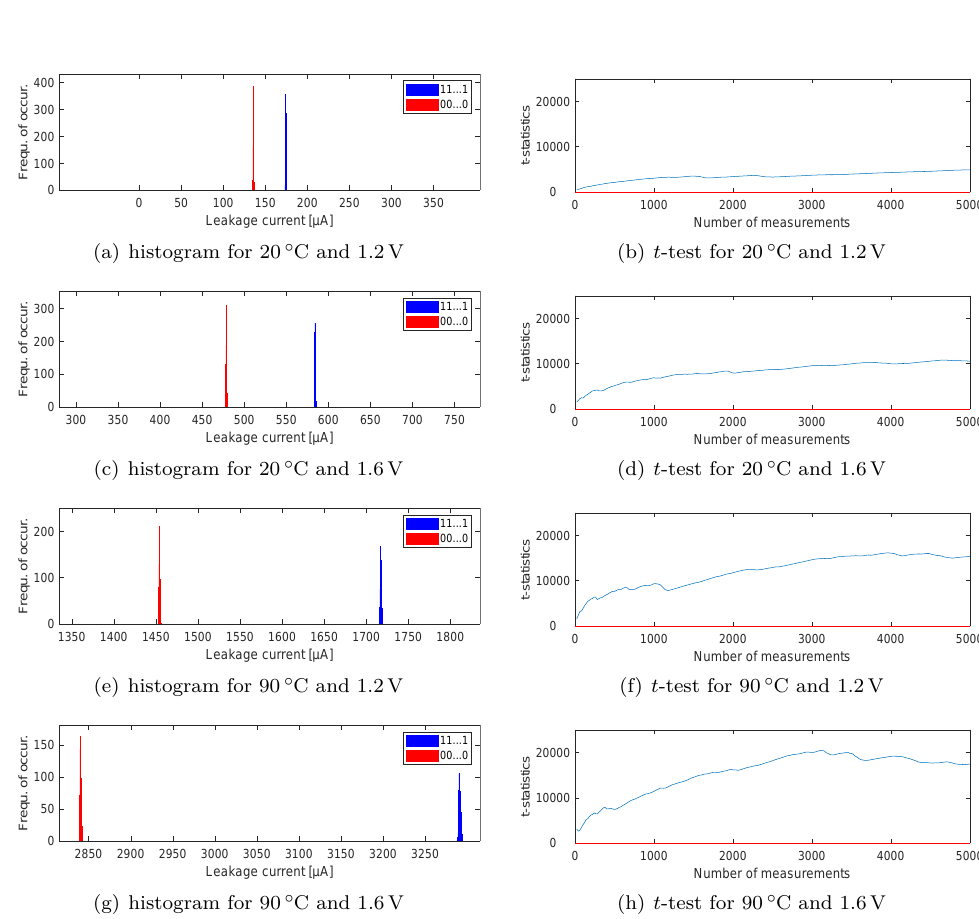
Figure 4: Histograms and t -test results for 5,000 static power measurements of a 1024-bit high-fanout register in 65 nm CMOS technology, filled either with only 1s or only 0s.